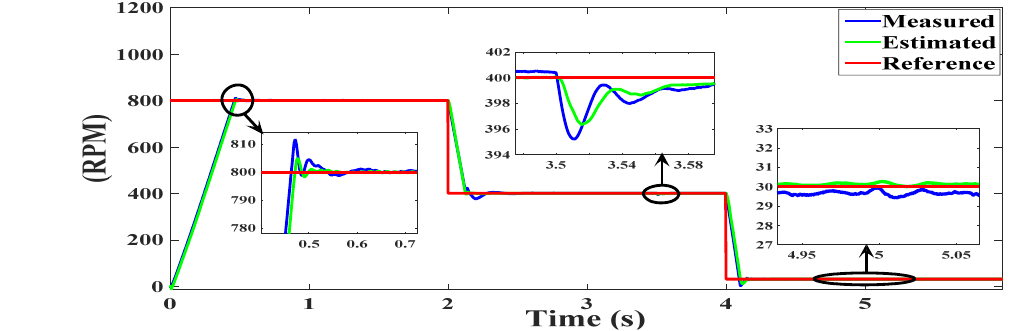
Figure 13. ( a ). Stator resistance variation under PTC ( Ω ), ( b ). Rs estimation error under PTC ( Ω ).